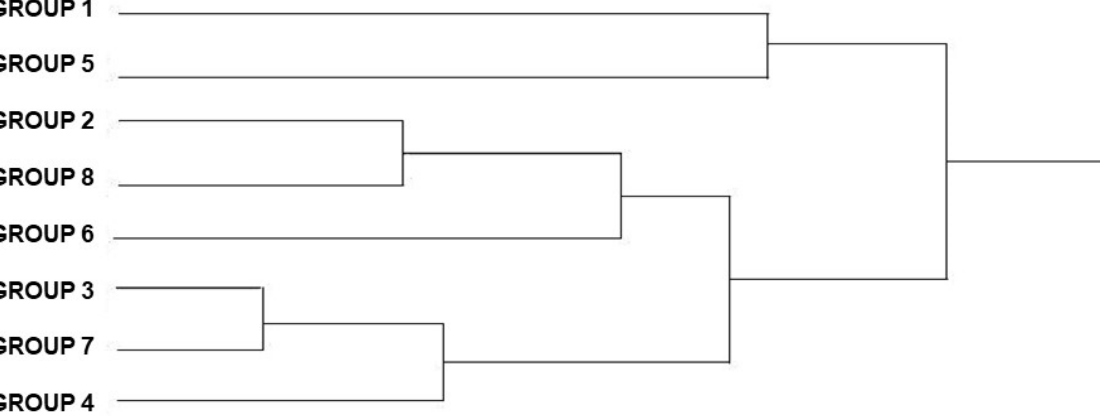
Figure 5. UPGMA Dendrogram of the Triatoma brasiliensis brasiliensis males, from various states and